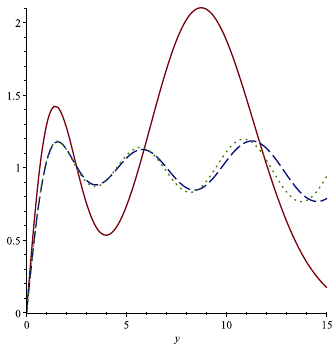
Figure 2. Approximations Φ l 5 (0 ,y ;1) (solid line), Φ l 7 (0 ,y ;1) (dashed line) and Φ l 9 (0 ,y ;1) (dotted line) to the function Φ (0 ,y ;1) in the interval [0 , 15] when respectively the first 5, 7 and 9 terms are used in the